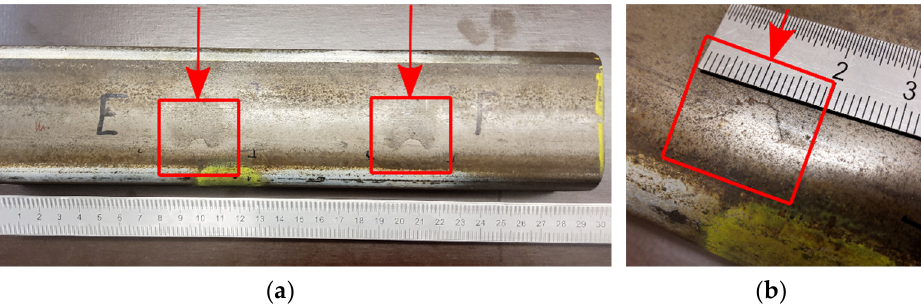
Figure 2. ( a ) A 300 mm rail piece with squats (RP02); ( b ) detailed picture of a large squat on the specimen; area with squats marked in red.